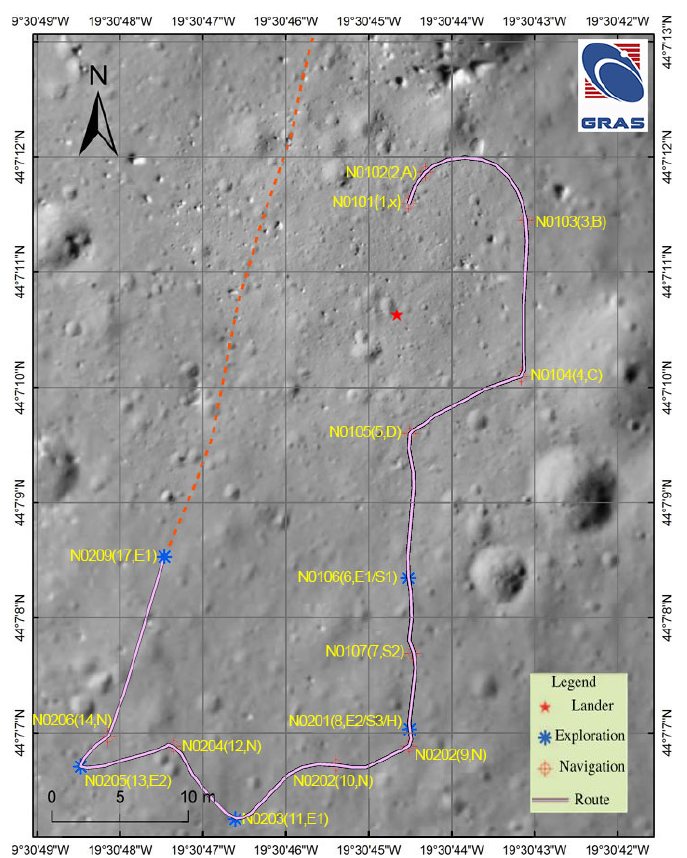
Figure 1. The Yutu Rover route sketch. PCAM (Panoramic Camera) working at “exploration”, navigation camera working at “navigation”. The red dotted line means planned future